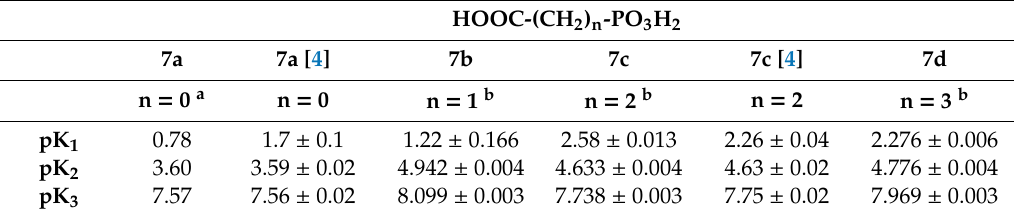
Table 10. Dissociation constants of phosphonocarboxylic acids HOOC-(CH 2 ) n -PO 3 H 2 (n = 0 to 3) 7a to 7d [8,44]. Experimental data: a) C Titrand : 0.153 mol / L FOSCARNET (trisodium phosphonoformate